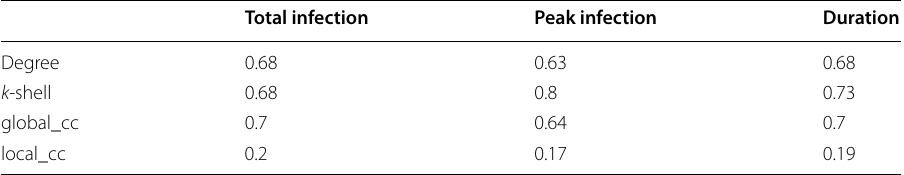
Table 2 Pearson correlations of the true spreading capability of nodes with the different measures in the Facebook